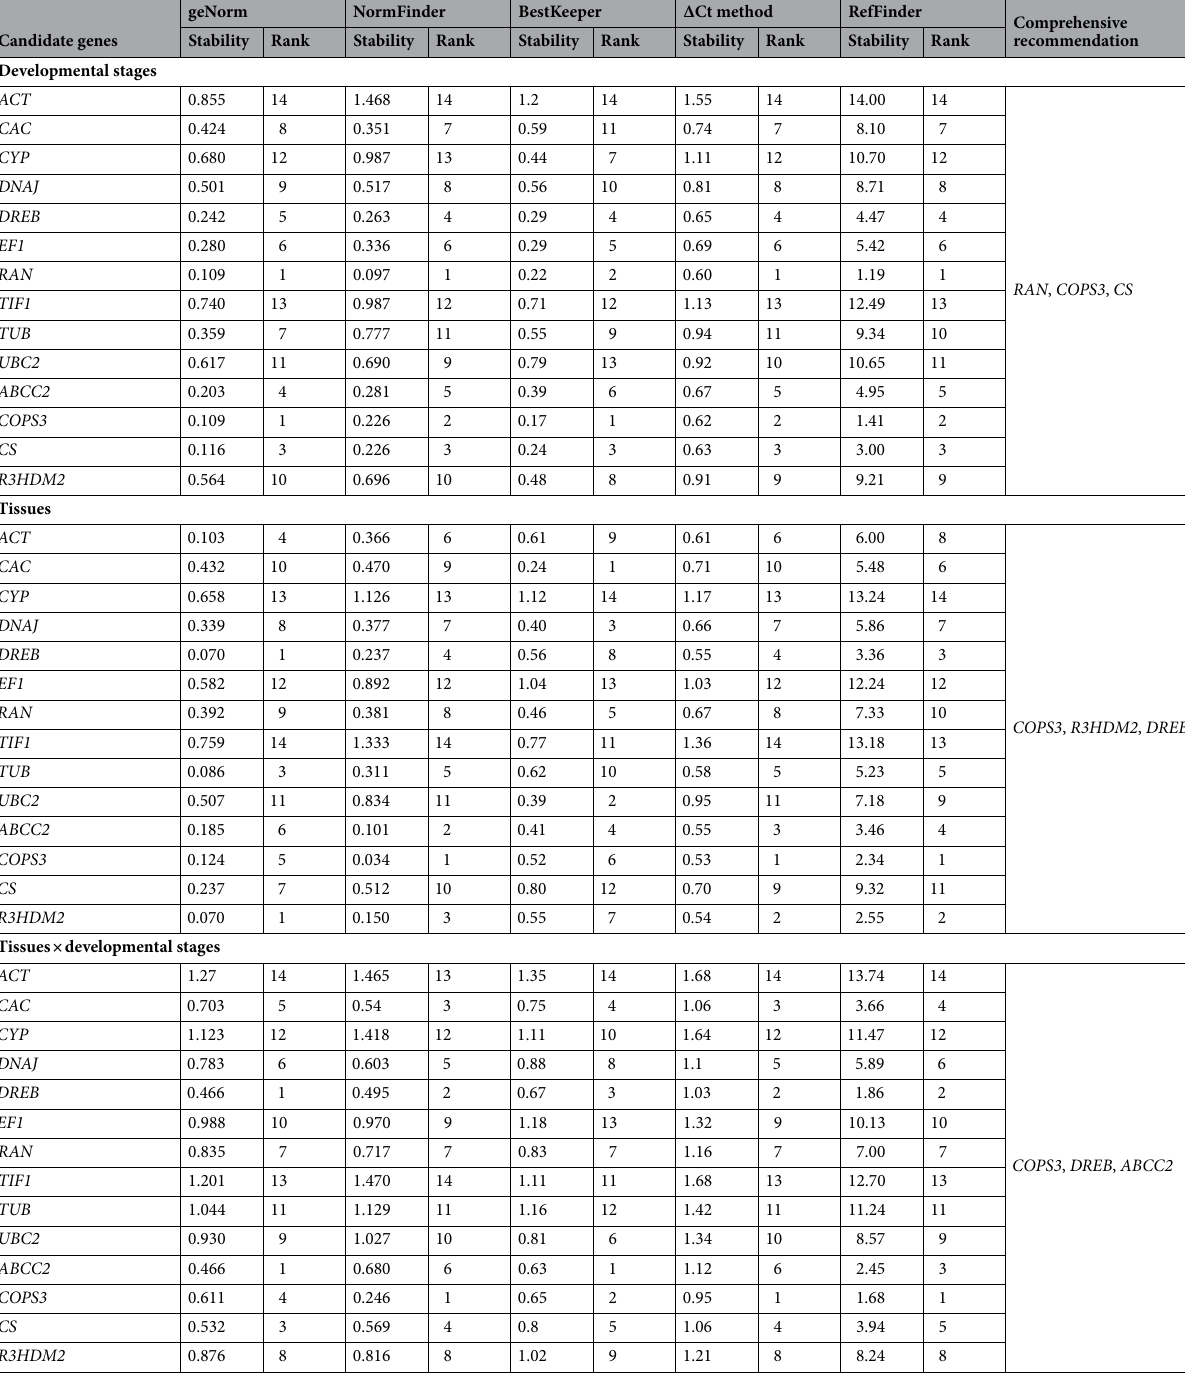
Table 3. Stability of candidate reference genes under different conditions in G. inflata